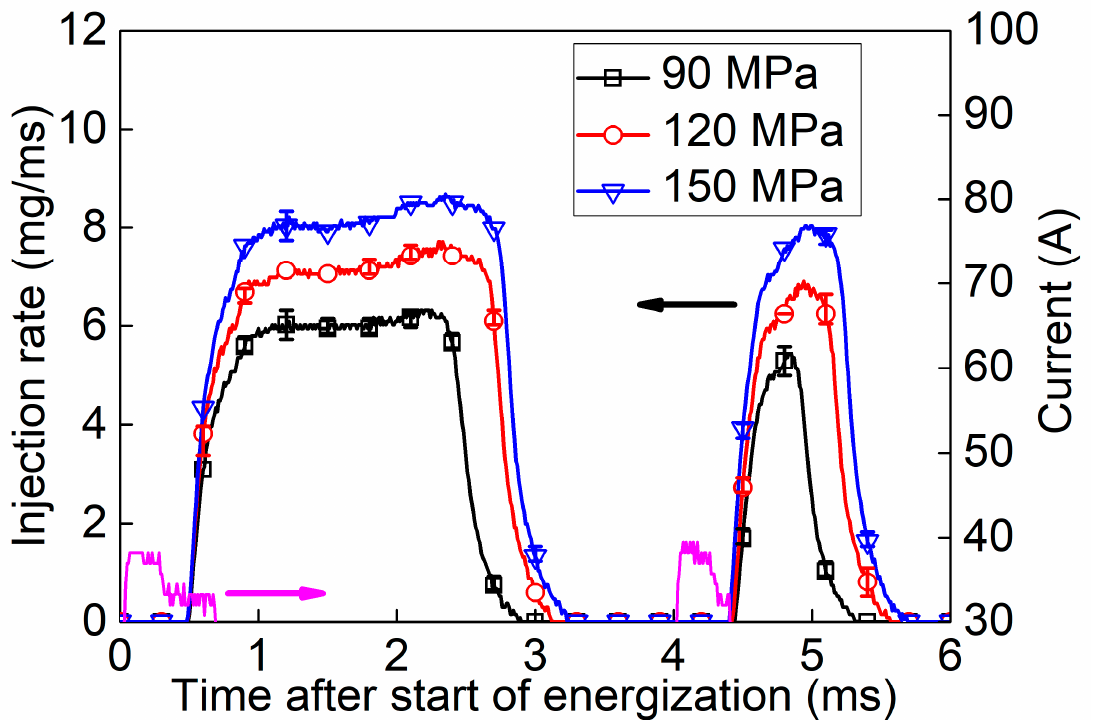
Figure 5. Results of injection rate for the main-post strategy.